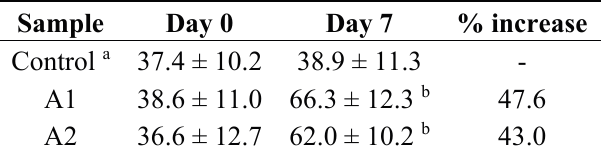
Table 4. Skin hydration before treatment (Day 0) and after 7 days treatment (Day 7) with emulsion A1 or A2.